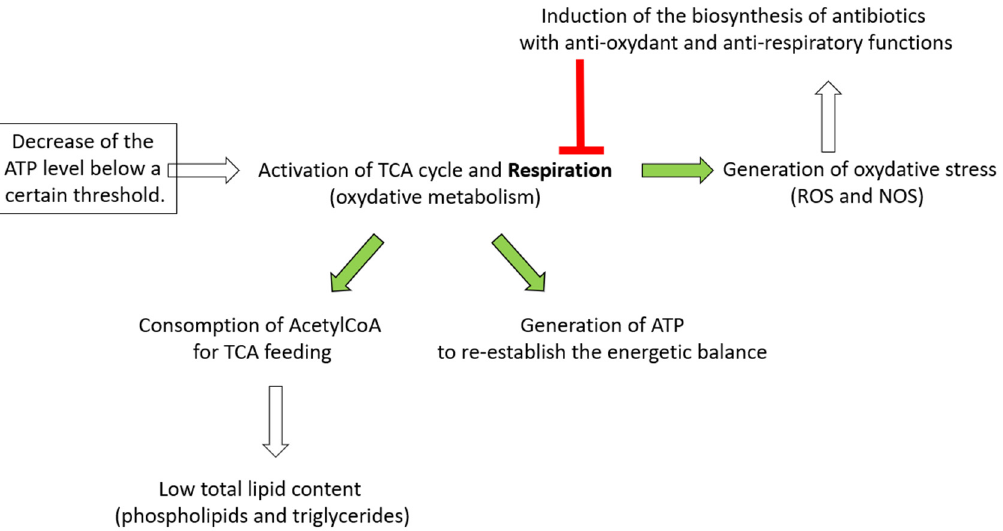
Figure 7. Schematic representation of the link between the lowering of the intracellular ATP concentration, the triggering of the biosynthesis of a specific class of bioactive specialized molecules and the negative role played by the latter in regulation of the respiratory activity of the producing